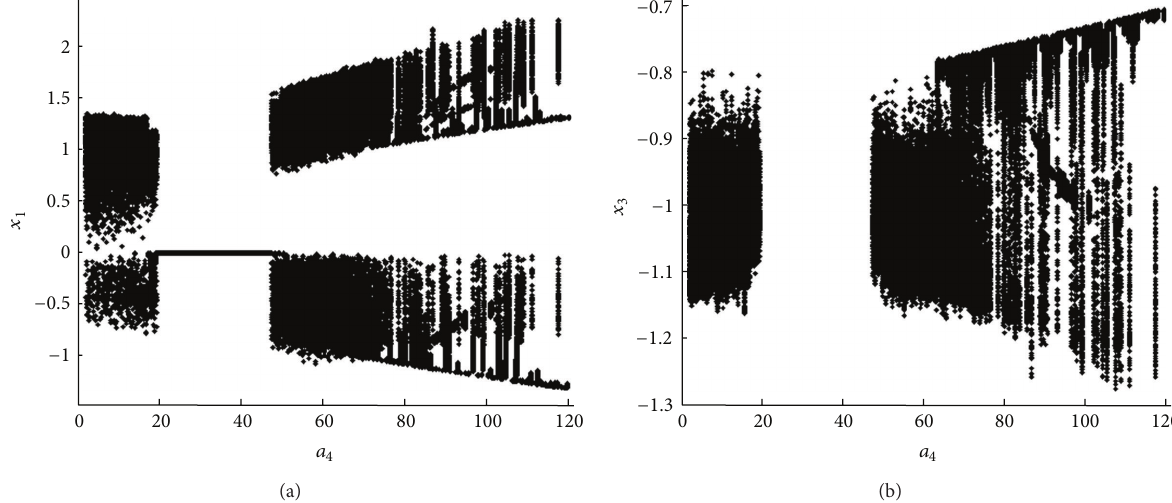
Figure 10: The bifurcation diagram is obtained for the piezoelectric excitations 𝑎 4 = 2 ∼ 120, 𝑓 2 = 55.1 , 𝜇 1 = 0.1 , 𝜇 2 = 0.1 , 𝑎 2 = 11.59 , and = 21.5 ; (a) the bifurcation diagram on the plane (𝑥 𝑎 3